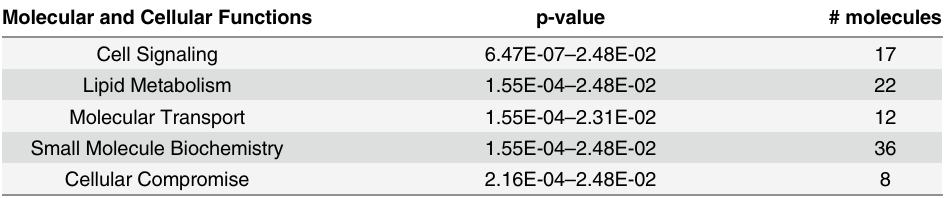
Table 2. The altered expression of genes within these networks may contribute to the impaired lactation observed in hNAG-1 females. Cidea , a transcriptional co-activator of C/EBP β in mammary glands, has been shown to reg- ulate the secretion of milk lipids from mammary glands of mice. Pups born to dams lacking the co-activator Cidea have reduced pup survival to PND3 with impaired milk lipid concentra- tions observed in Cidea -/- dams compared to Cidea +/- dams [29]. Cidea -/- mice are lean with Table 2. Top Molecular and Cellular